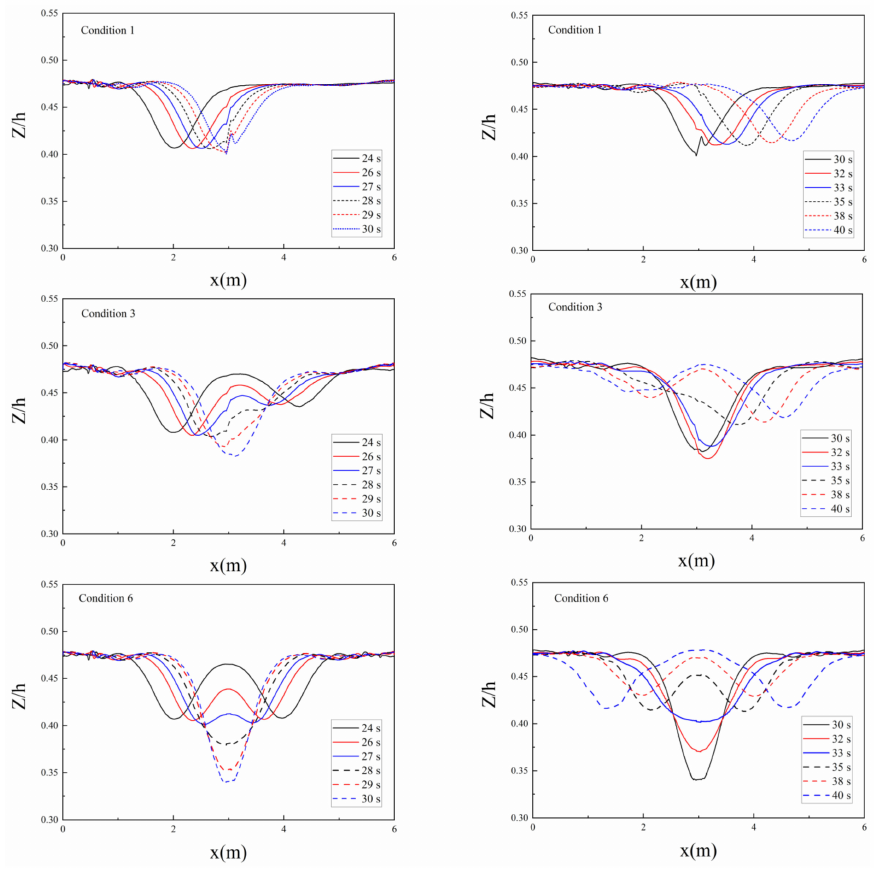
Figure 8. Waveform